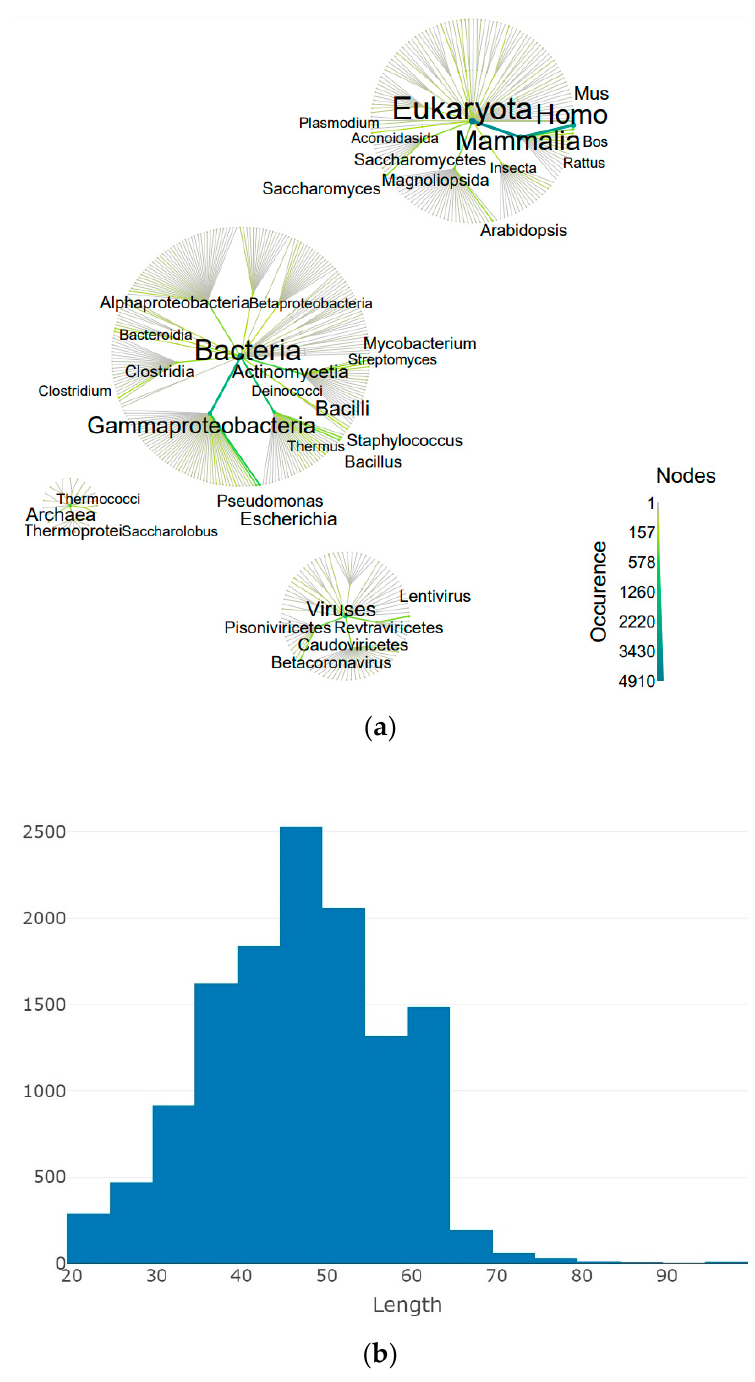
Figure 2. ( a ) Origin of proteins in which 3 β -corners have been identified. The taxonomic community is revealed by a heat tree map, showing the taxonomic context from higher ranks in the center to lower ranks in peripheries (kingdom to class). The abundance of species (occurrence) can be quantified and visualized by color and size of the nodes and edges. Graph components, such as the size and color of text, nodes, and edges, allow for the quantitative representation of multiple statistics simultaneously. Each node represents a taxon, and the edges determine where the taxon fits within the overall taxonomic hierarchy. Edge width is proportional to the number of taxa; ( b ) length distribution of 3 β -corners in the examined dataset ( n = 12,852, see Supplementary materials, TableS1).